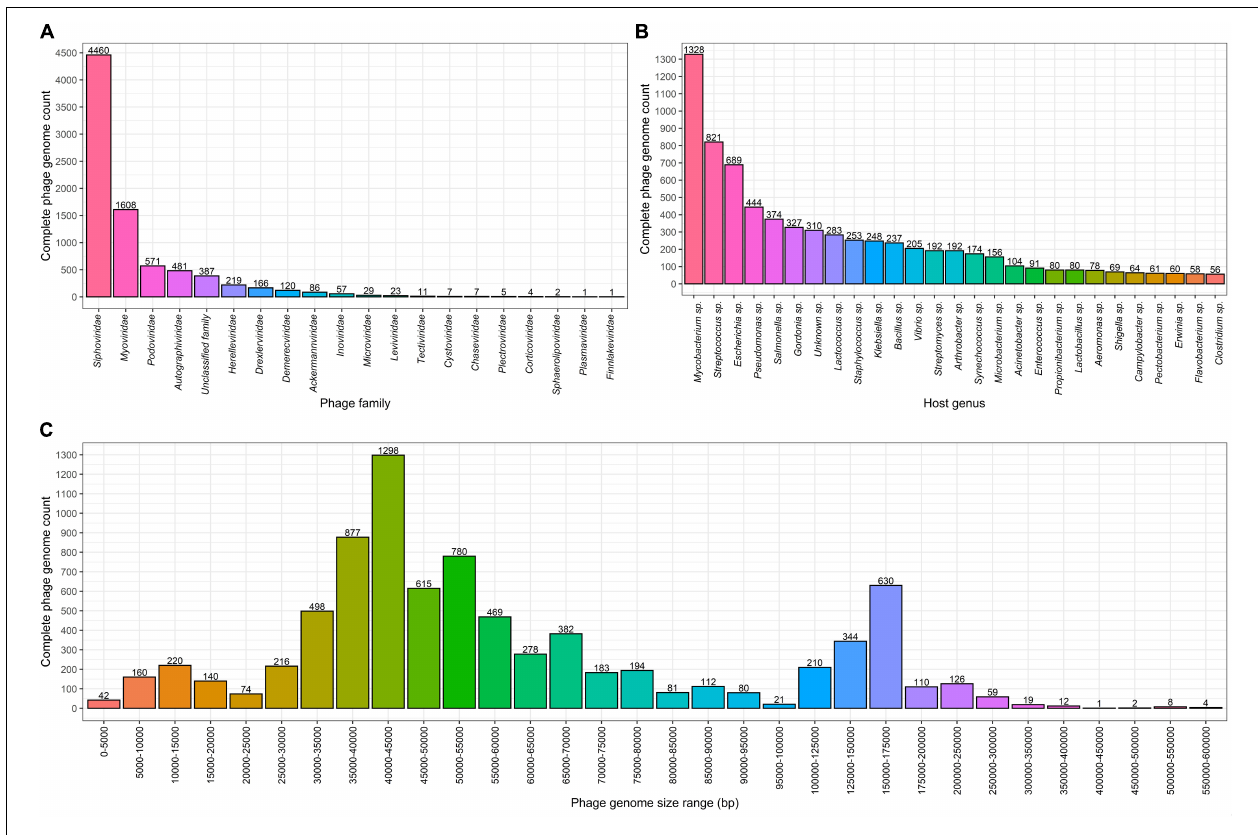
FIGURE 1 | Complete bacteriophage genome count distributions (as of 02.06.2020). Numbers above the bars in each graph indicate complete genome counts (Y) for corresponding X values. (A) Completely sequenced bacteriophage genome distribution among viral families where viruses of bacteria are found. The x axis represents viral families that include completely sequenced bacteriophage genomes. (B) Number of bacteriophages infecting bacterial host genera for which 50 or more infecting bacteriophage complete genomes sequences are available. The x axis show bacterial species for which 50 or more corresponding